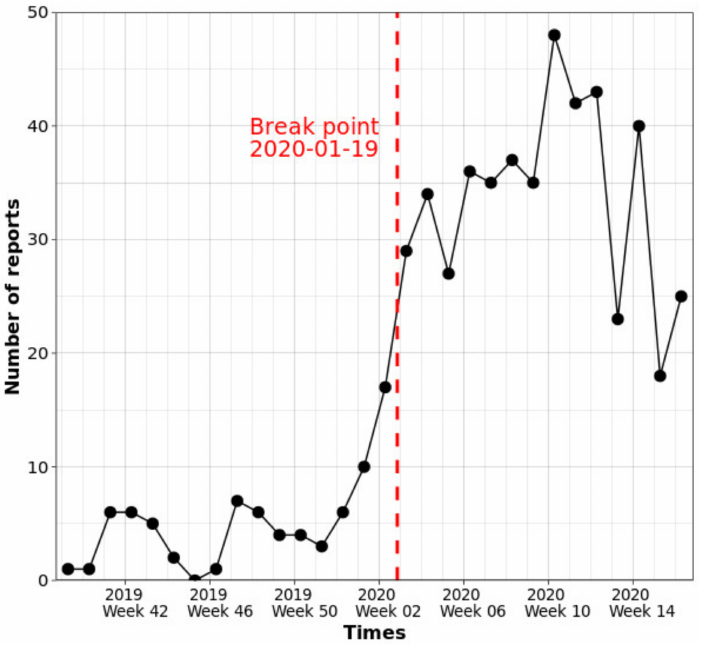
Figure 1. Time series plot for the number of reported ASF-positive wild boar carcasses per week from October 2019 to April 2020: the red dashed vertical line shows the break point on 19 January 2020.